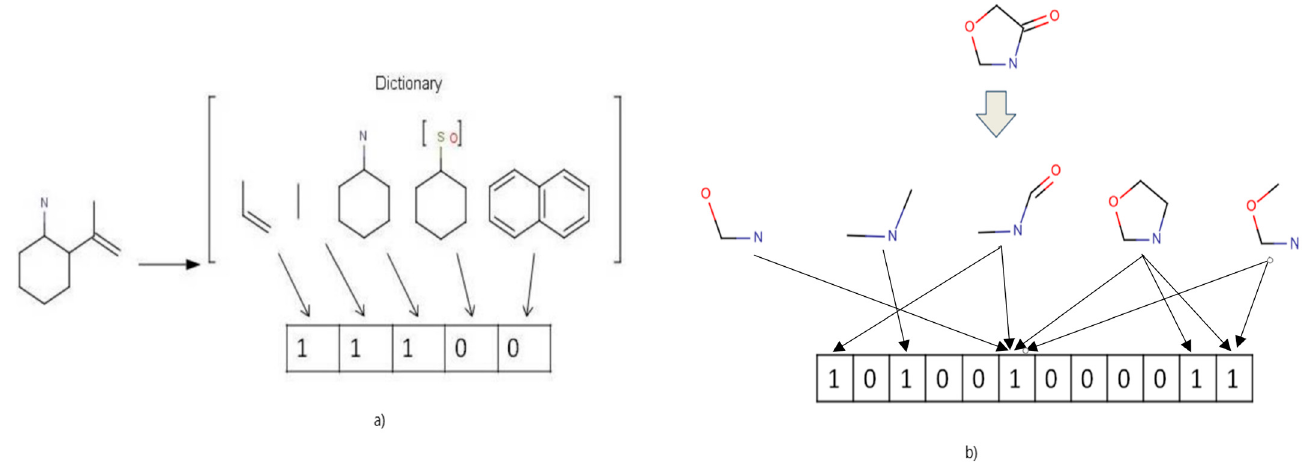
Figure 1. Two examples showing the generation of a molecular fingerprint: ( a ) Dictionary-based fingerprint and ( b ) hashed-based fingerprint.